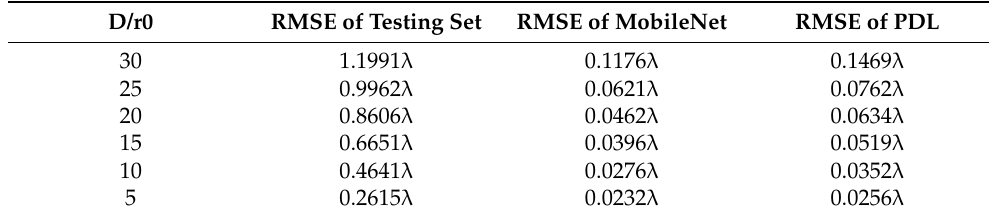
Table 2. Comparison of the accuracies (RMSE) of the equivalent wave-fronts from the Zernike coefficients estimated in the experiments between PDL and MobileNet with different D/r0 (3–20 order). D/r0 RMSE of Testing Set